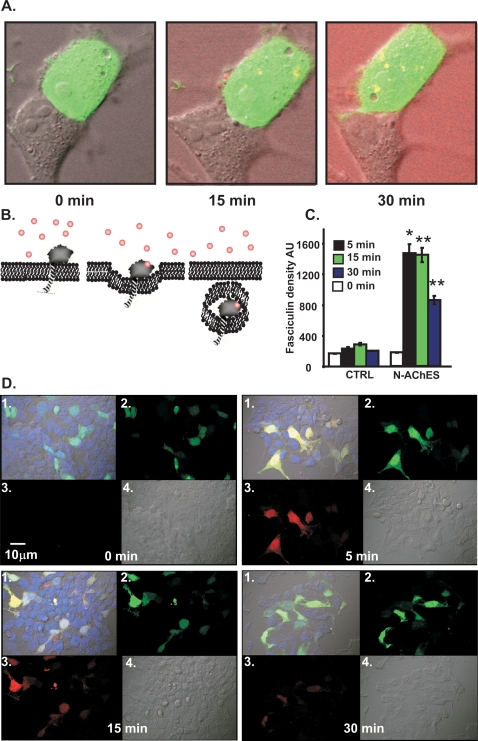
N-AChE-S Membranal localization and Fasciculin-2 Internalization.A. Fasciculin-2 internalization. Tetramethylrodhamine labeled Fasciculin2 was added to the medium of 293 cells co-transfected with N-AChE-S and GFP. Shown is internalization of labeled Fasciculin 2 yielding fluorescence into N-AChE-S transfected, but not non-transfected cells at 15 and 30 minutes. Pictures were taken by live imaging. B. Schematic representation of N-AChE-S in the cell membrane and its internalization. C. Tetramethylrodhamine labeled Fasciculin2 was add to the medium of N-AChE-S and GFP co-transfected 293 cells were fixed after: 0,5,15 and 30 min. The density of Fasciculin2 was measured. Columns show density in N-AChE-S transfected vs non-transfected cells at the noted times (*p>0.05, **p>0.005 Student's t test). D. Representative pictures of the experiment quantifies in C.1.Merge picture (yellow fluorescence notes Fasciculin2 internalization into GFP-expressing cells). 2. Co-transfected GFP and N-AChE-S cells. 3. Fasciculin-2 internalized 4.Light picture.